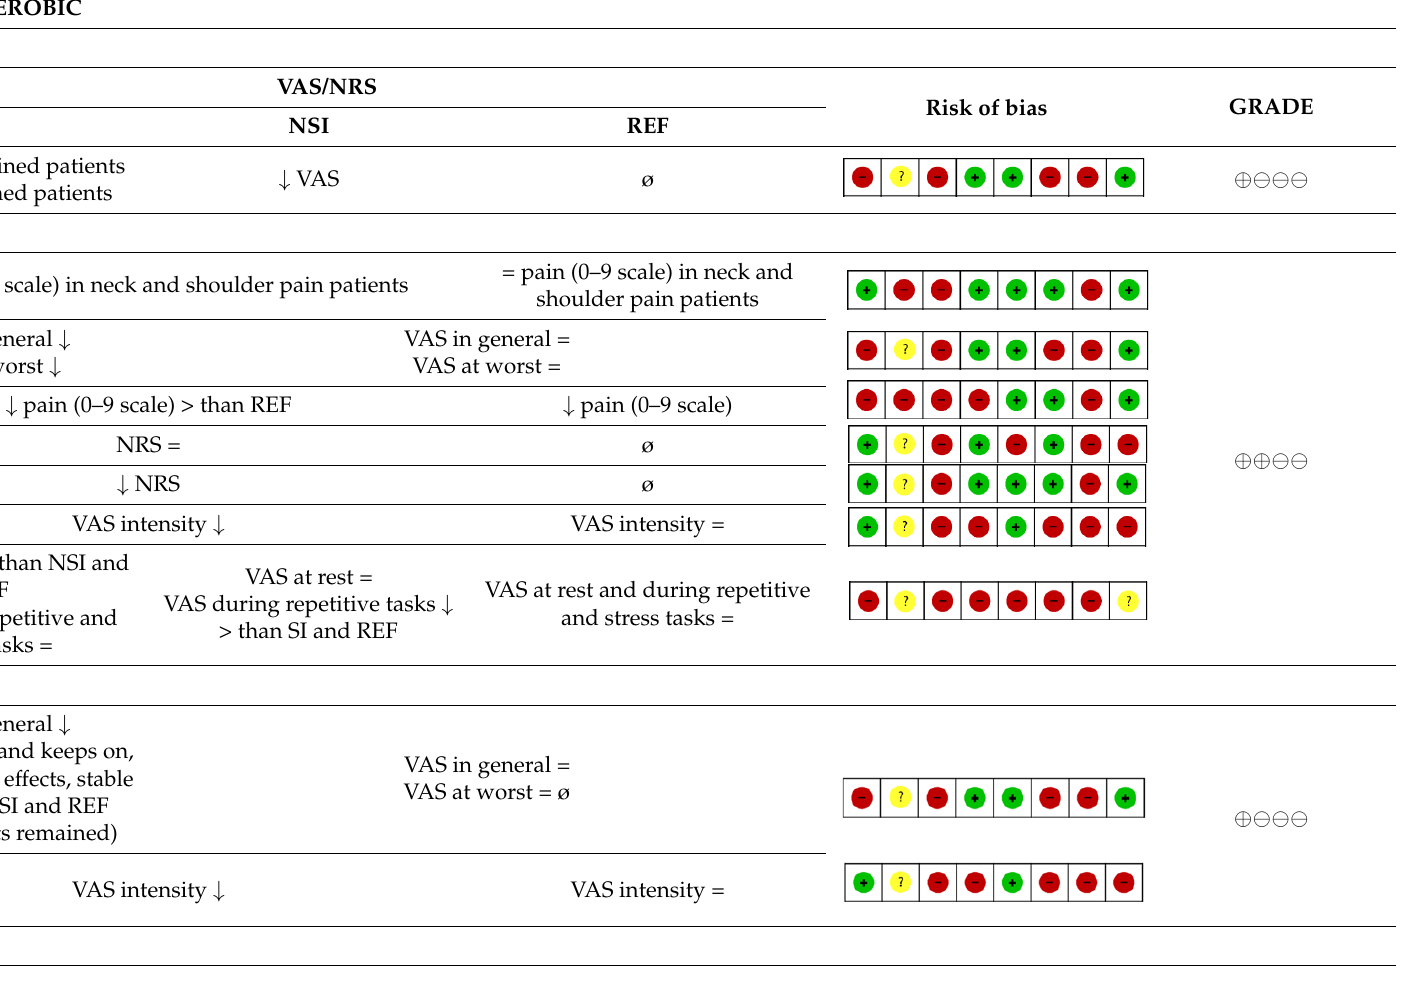
Table 2. Risk of bias and grading the evidence per clusters based on exercise type and exercise effects over time OR follow-up (acute, short- and long-term effects).